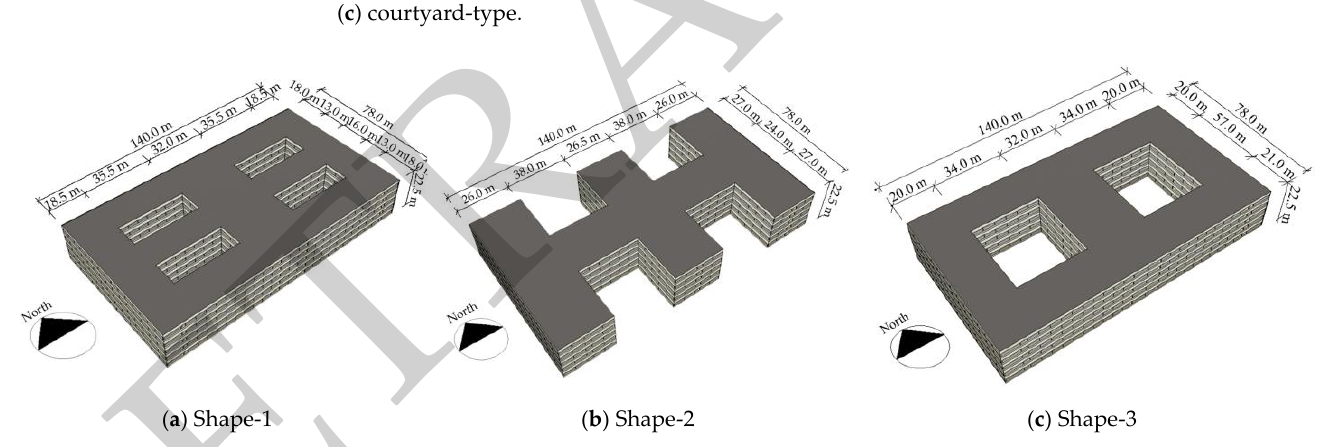
Figure 5. The basic information of three typical models: ( a ) centralized-type; ( b ) corridor-type; and ( c ) courtyard-type.